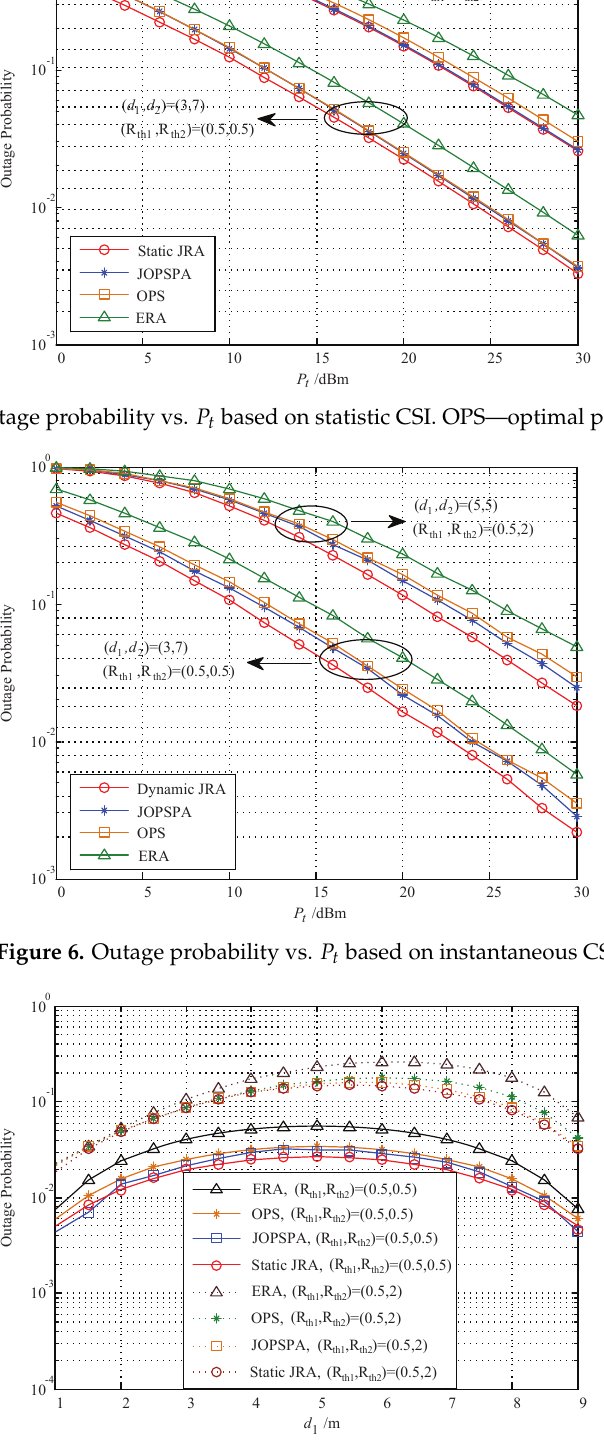
Figure 7. Outage probability vs. d 1 based on statistic